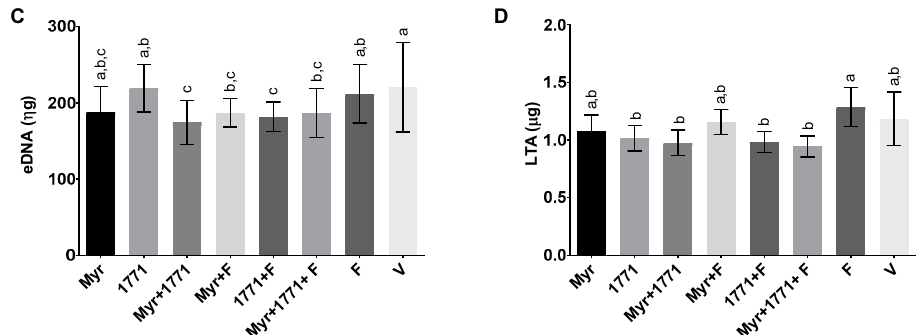
Figure6. Modulationoftheextracellularmatrixcomponentsinthetopicallytreatedbiofilms. Thegraphs Figure 6. Modulation of the extracellular matrix components in the topically treated biofilms. The graphs exhibit the content of water-soluble exopolysaccharides (EPS) ( A ), water-insoluble EPS ( B ), eDNA ( C ), and